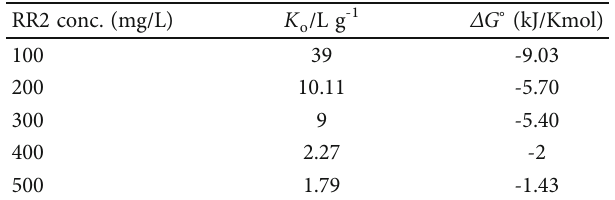
Figure 9: The pseudosecond-order kinetic plots for RR2 adsorption on GWAC (a) type 1: the pseudosecond-order, (b) type 2: the pseudosecond-order, (c) type 3: the pseudosecond-order, and (d) type 4: the pseudosecond-order. Table 6: Kinetic model parameters and correlation coe ffi cients for RR2 adsorption on GWAC.